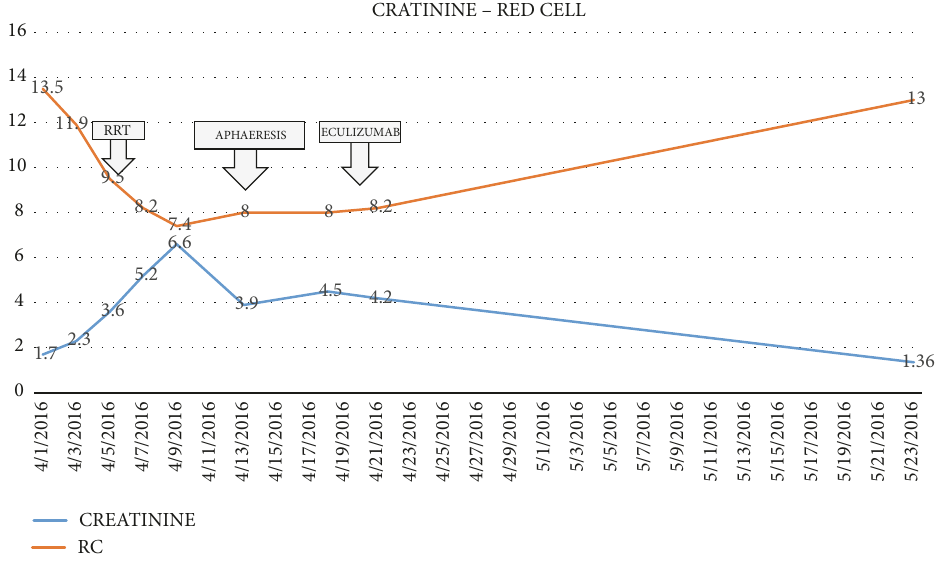
Figure 3: Initial increase of creatinine levels showing decrease of renal function and decrease of red blood cells, hemolytic anemia, the breaking point on day 9, after 10 days after trying with RRT and aphaeresis Eculizumab therapy was started with a subsequently recovery of red cell line and creatinine level.